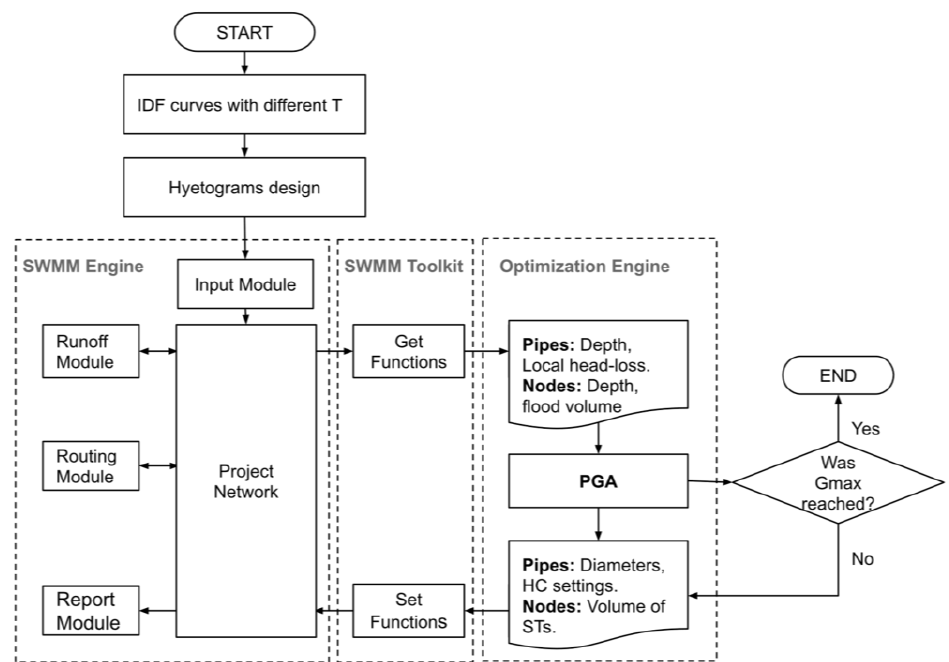
Figure 2. Schematic diagram of the optimization model.